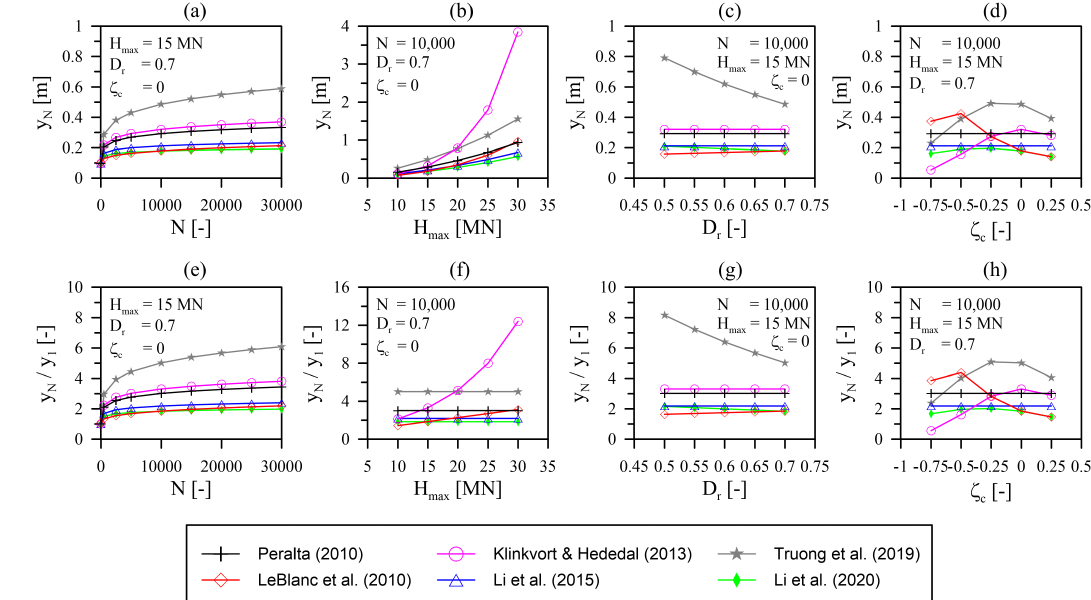
Figure 2. Results of the parameter study on the pile head displacement accumulation and the influence of different input variables: compar- ison of the prediction models given in Table